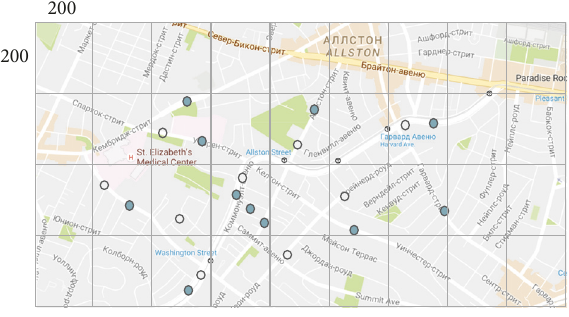
Figure 2: Type of coordinate